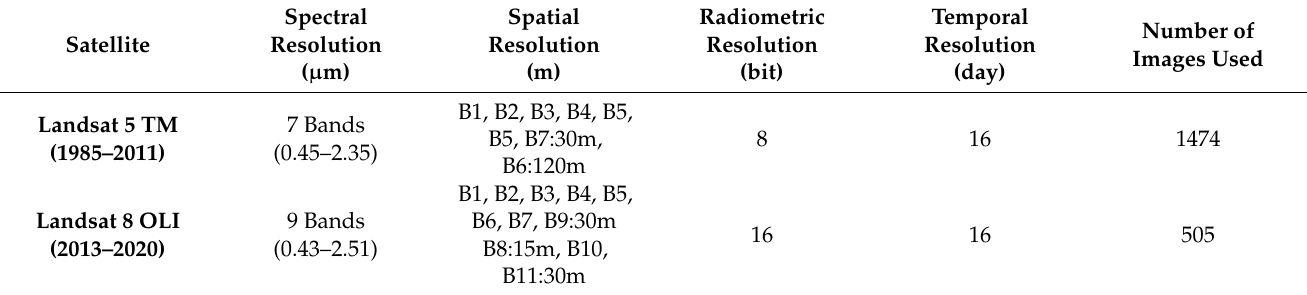
Table 5. Information on satellite imageries used [71,72].